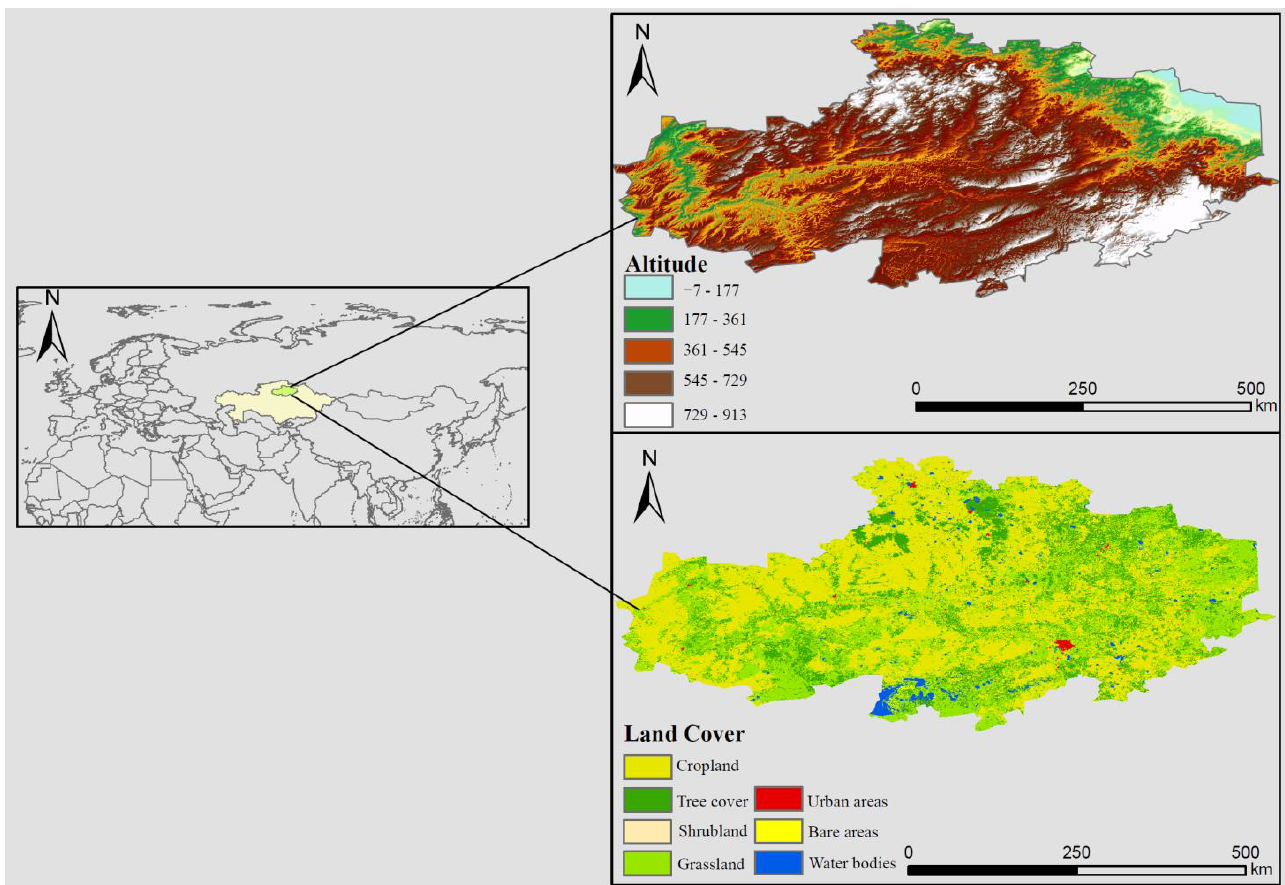
Figure 1. Overview map of the study area.